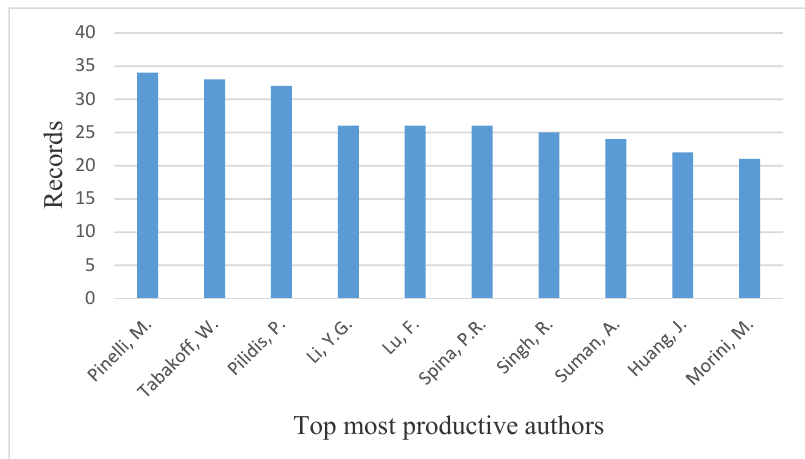
Energies 2021 , 14 , x FOR PEER REVIEW Figure 4. List of top 10 authors in terms of published articles. Figure 4. List of top 10 authors in terms of published articles.